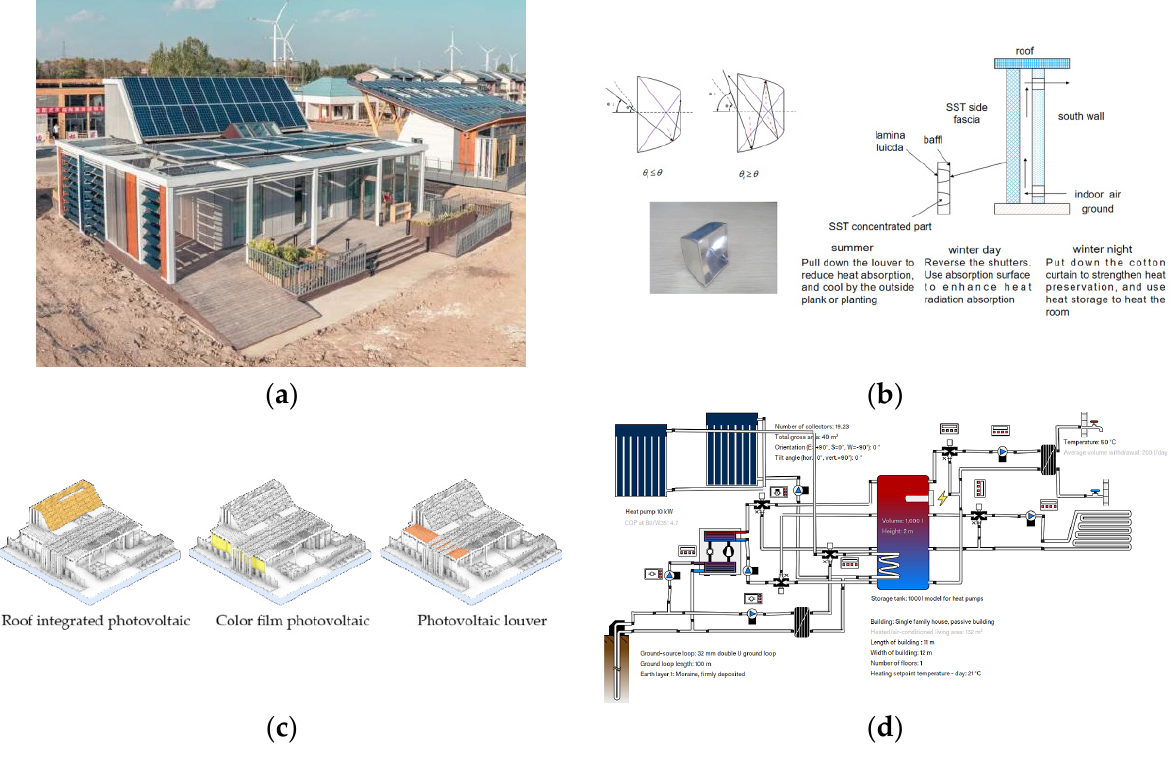
Figure 10. Main results of the T&A House. ( a ) Assembled T&A House. ( b ) SST wall. ( c ) PV used. ( d ) Ground source heat pump system.